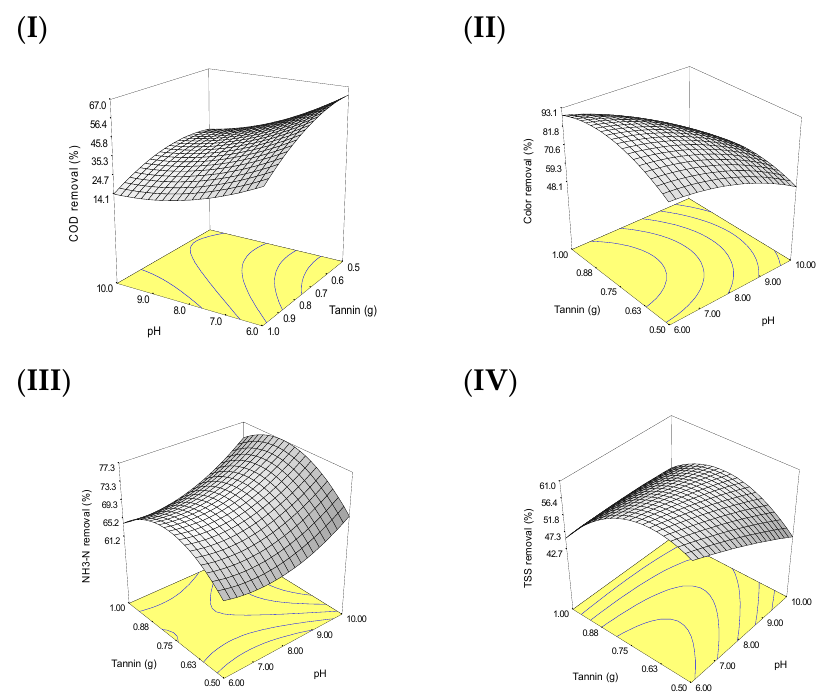
Figure6. Responsesurfaceplotsfor( I )COD,( II )color, ( III )NH 3 –Nand( IV Figure 6. Response surface plots for ( I ) COD, ( II ) color, ( III ) NH 3 –N and ( IV ) TSS removals from leachate.